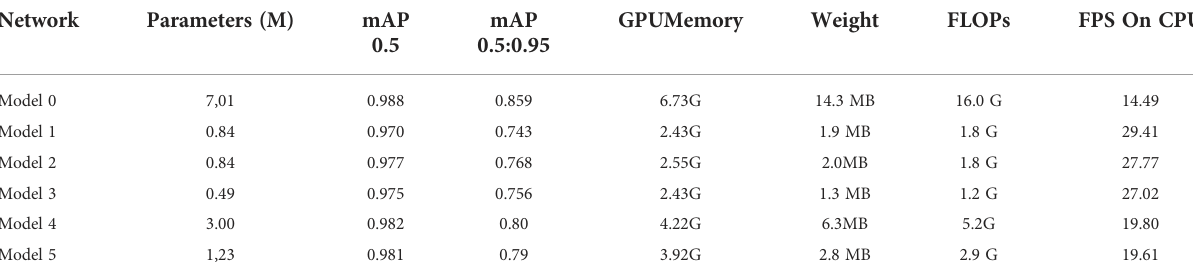
TABLE 3 Datasheet of ablation experiment results.